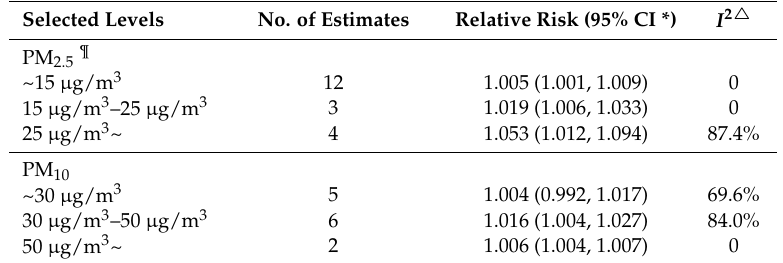
Table 2. Association between particulate matter (PM 2.5 and PM 10) and hospitalization or mortality due to arrhythmia stratified by pollutant concentrations.